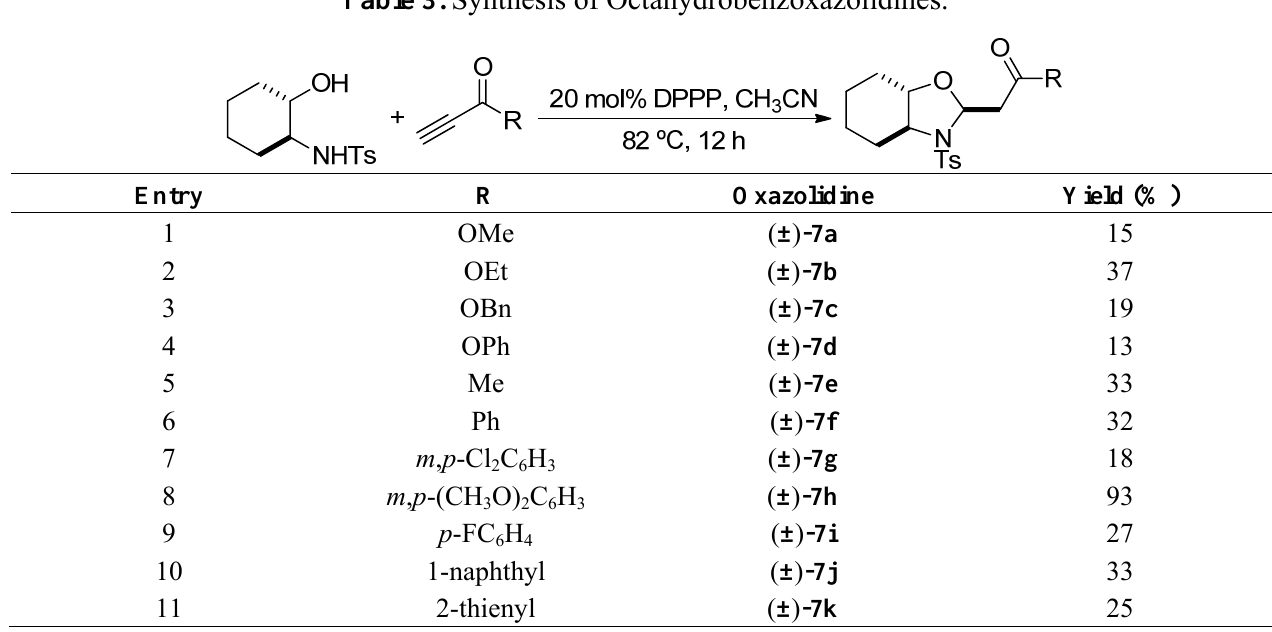
Table 3. Synthesis of Octahydrobenzoxazolidines.